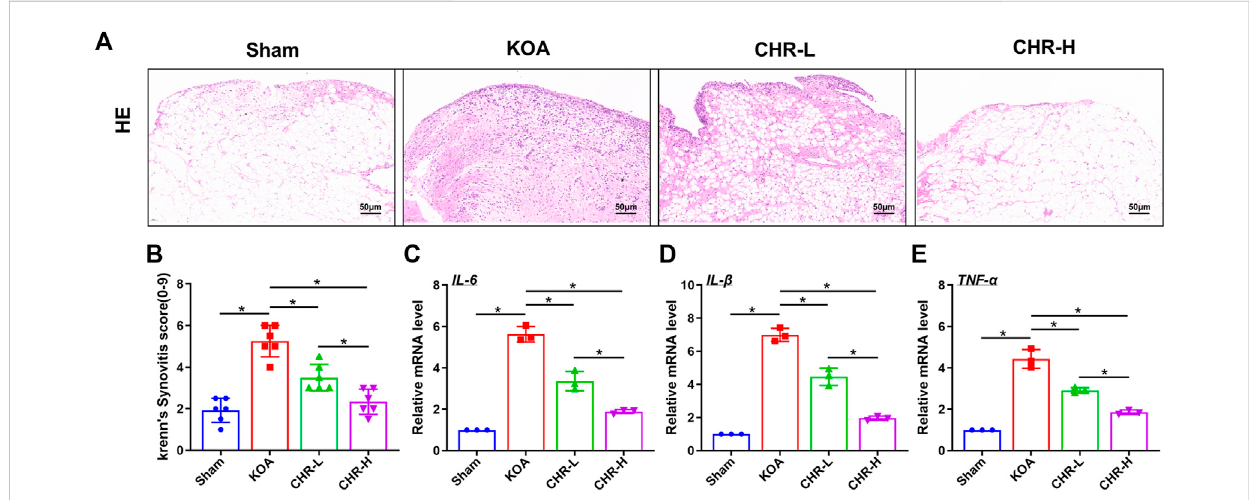
CHRreducessynovialin fl ammationinKOArats. (A) RepresentativeimagesshowingH&Estainingofthesynoviumat×200magni fi cation.n=6.Scale bars: 50 μ m (B) Quantitative analysis of the synovitis score. (C – E) Quantitative PCR analysis of IL-6, IL-1 β and TNF- α in synovial tissue in each group. n = 3 per group. The data in this fi gure are presented as the mean ± standard deviation, and statistical signi fi cance was determined with one-way ANOVA followed by Tukey ’ s post hoc analysis. p p <